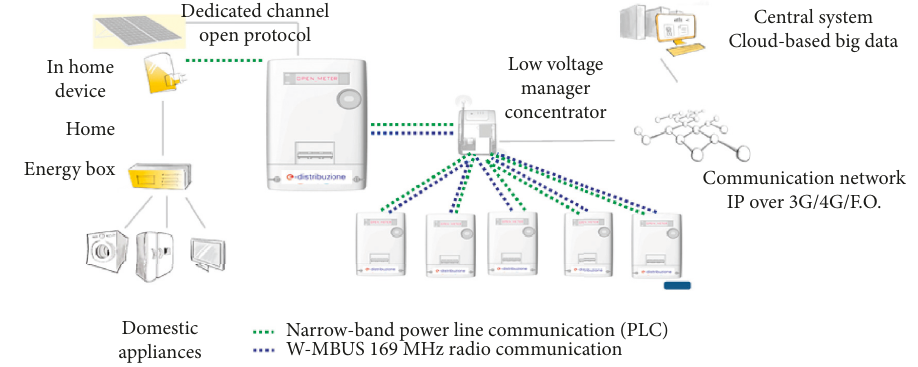
Figure 3: Open meter: the system